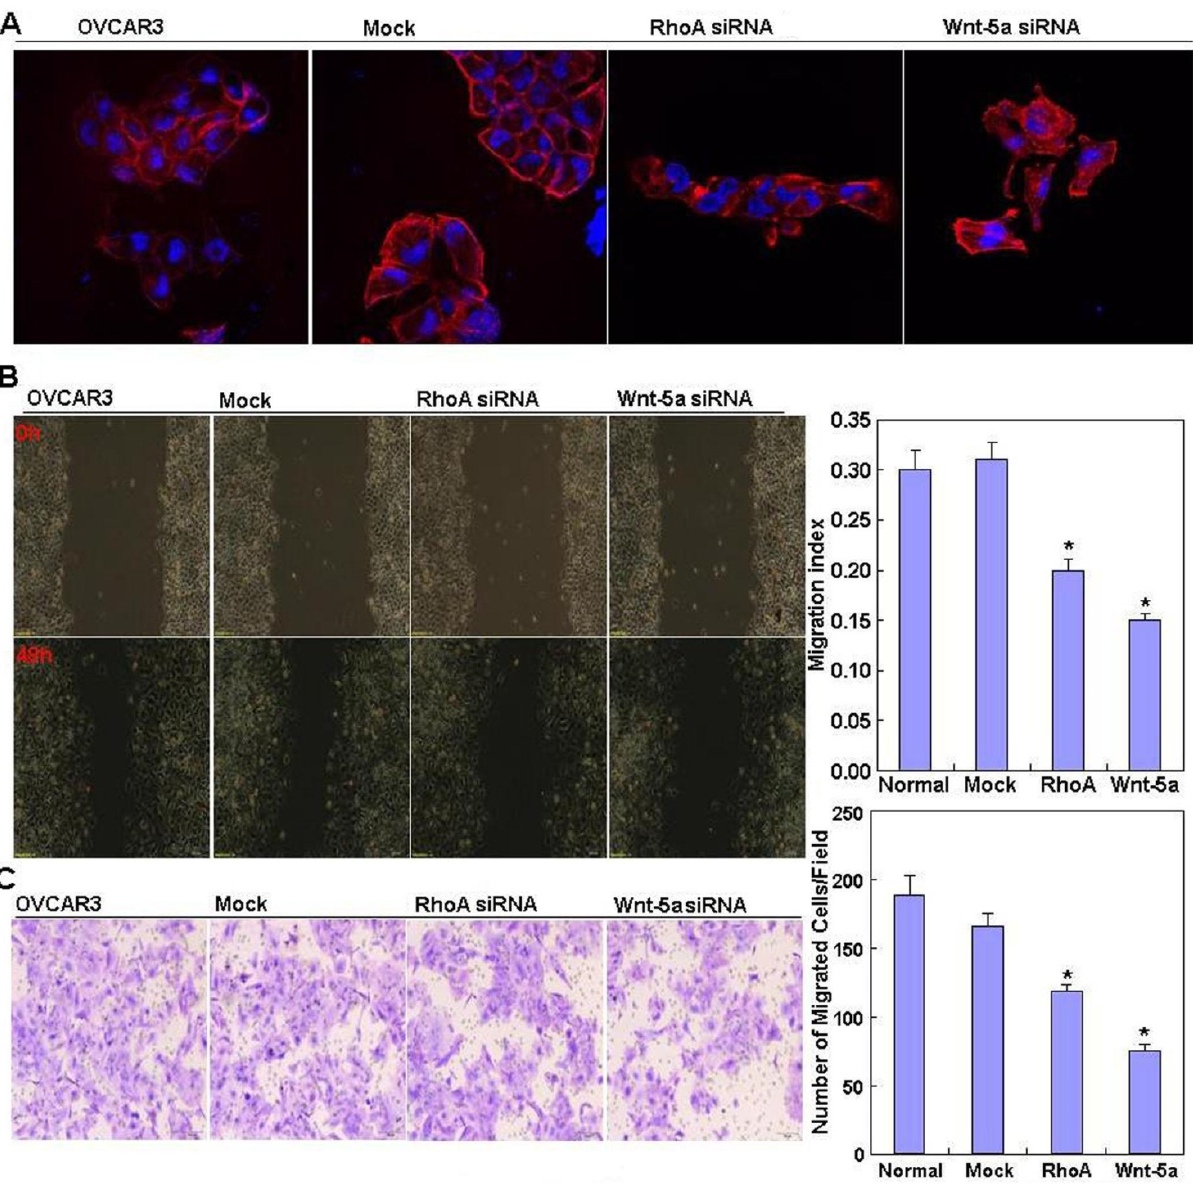
Figure 3. Effects of RhoA or Wnt-5a knockdown on the invasive ability of OVCAR3 cells. ( A – C ) OVCAR3 cells transfected with RhoA siRNA or Wnt-5a siRNA exhibited suppressed lamellipodia formation ( A ) magnification ×40; significantly reduced migration ( B ), Scale bar = 200 μ m; and significantly reduced cell invasion ( C ) in comparison with NC and mock-transfected cells, magnification ×20. * p < 0.05. Results are representative of three separate experiments; data are expressed as the mean ± standard